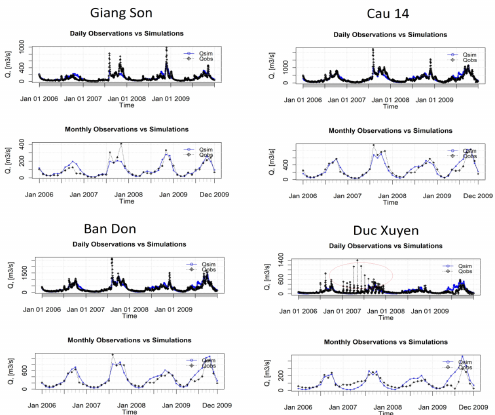
Fig. 10: Daily and monthly HYPE discharge compared to measured data in the model validation for the 2006-2009 periods at Giang Son, Cau 14, Ban Don and Duc Xuyen stations.